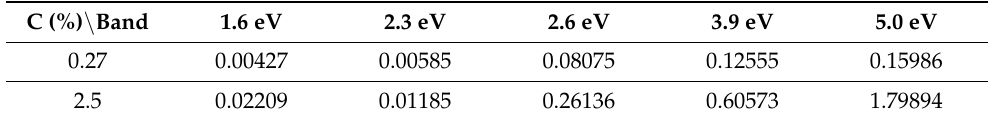
Table 2. Intensities for different absorption bands in the Kubelka–Munk function for TNT–MgO composites with TNT concentrations of 0.27% and